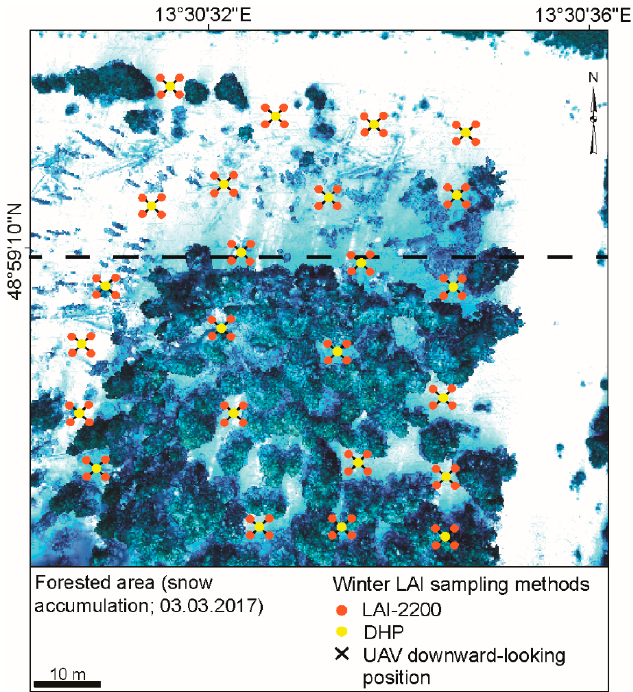
Figure 3. The position of all leaf area index (LAI) field surveys are displaying 24 points. Green points present the digital hemispherical photography (DHP) position. Orange points correspond to the LAI- 2200 canopy analyzer measurements as the average of four individual LAI values measured in a cross shape with 1 m distance from the cross arm ends to the center. The blue cross signs show the position of downward-looking images as seen from the UAV performance by the camera used for the LAI retrieval. Black dashed line indicates the border between healthy and bark beetle-damaged forest stand.